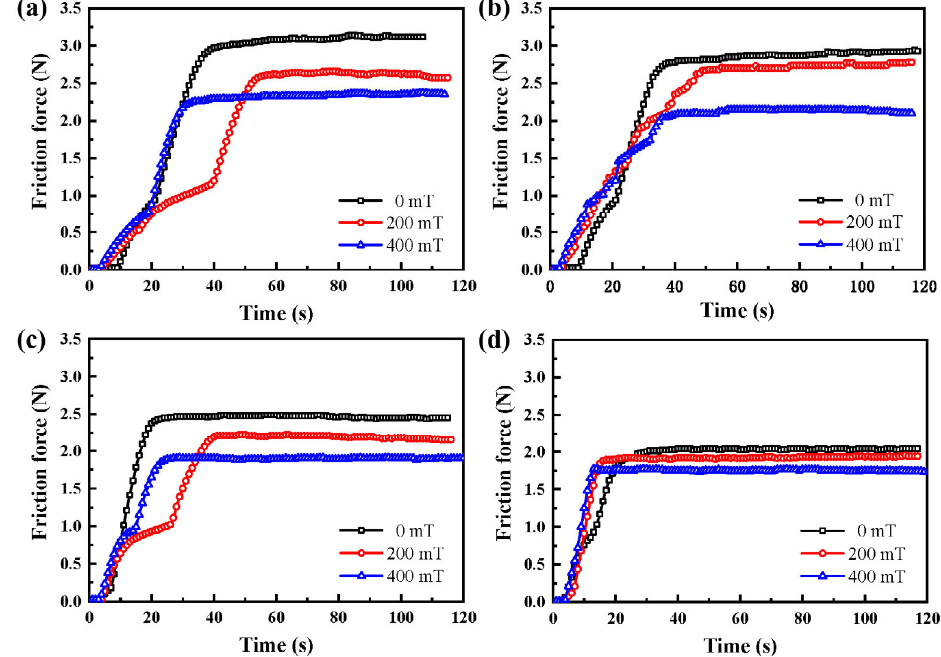
Fig. 15 The curves of friction with time: (a) 5%, (b) 10%, (c) 15%, and (d)